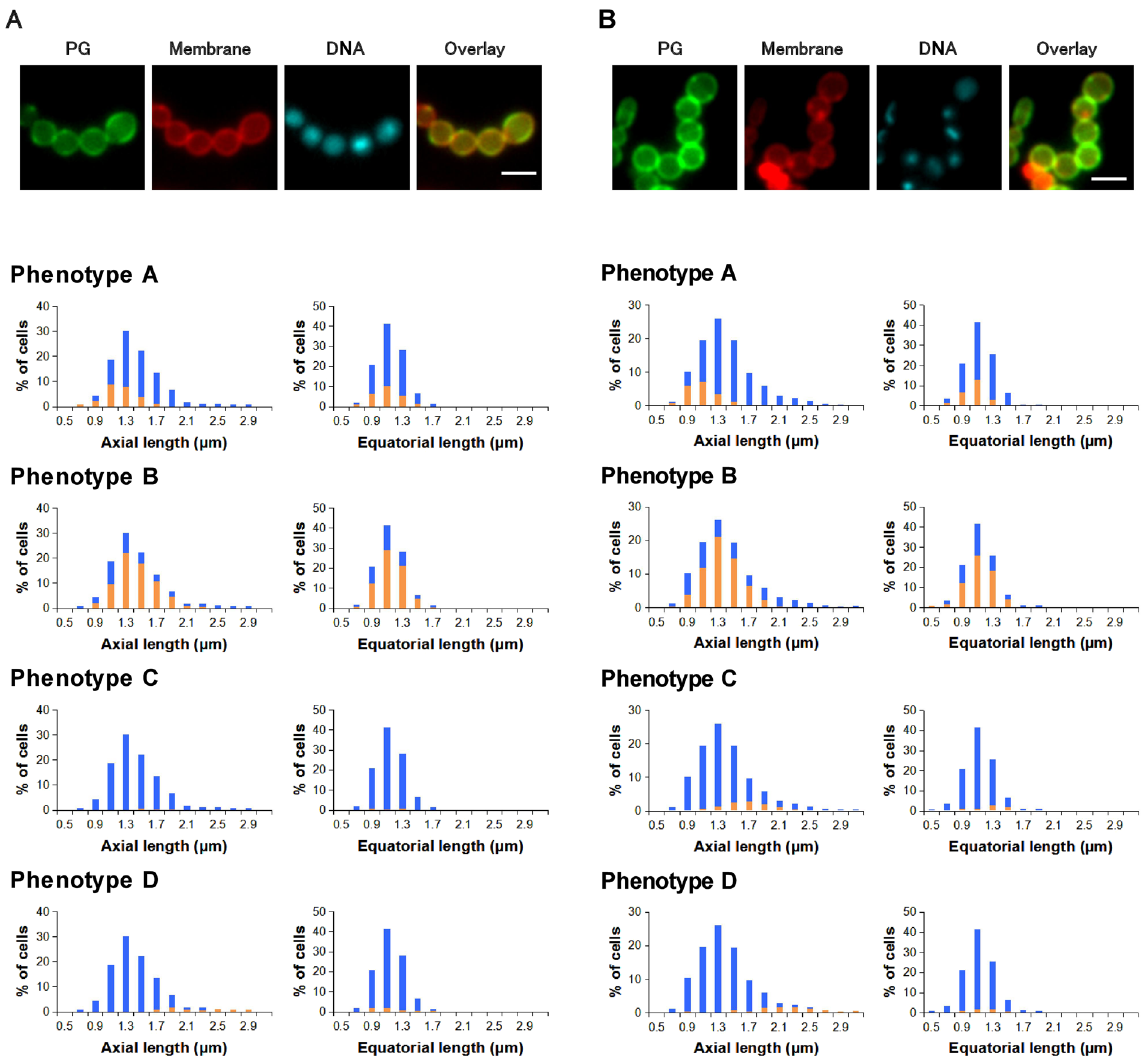
Figure 4. Average distribution of cell sizes and phenotypes of d -cycloserine (100 μ g/mL)-treated Streptococcus pyogenes ( A ) and oxacillin (4 μ g/mL)-treated S . pyogenes ( B ) (n = 3). Images: PG (growing peptidoglycan stained using the sortase method), Membrane (Nile red staining), DNA (DAPI), and Overlay (overlay of PG and Membrane images); scale bar: 2 μ m. Blue bars in histograms represent the cell size distribution of all cells. Orange bars in histograms represent the size distribution cells with the indicated phenotypes. Statistical analysis regarding the histograms is available in Supplementary Table